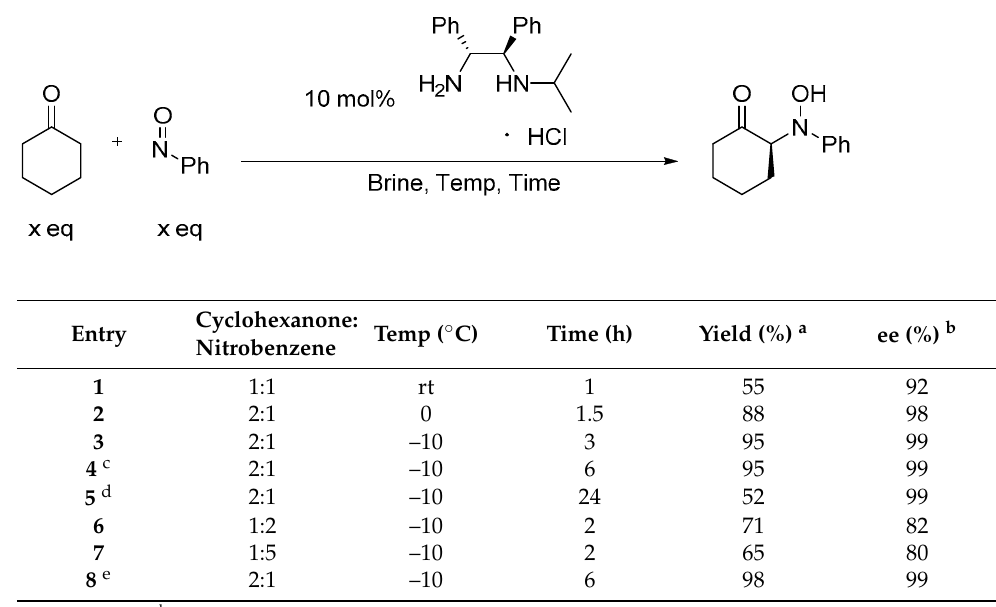
Table 3. Effects of temperature and different equivalent conditions on the nitroso aldol reaction.